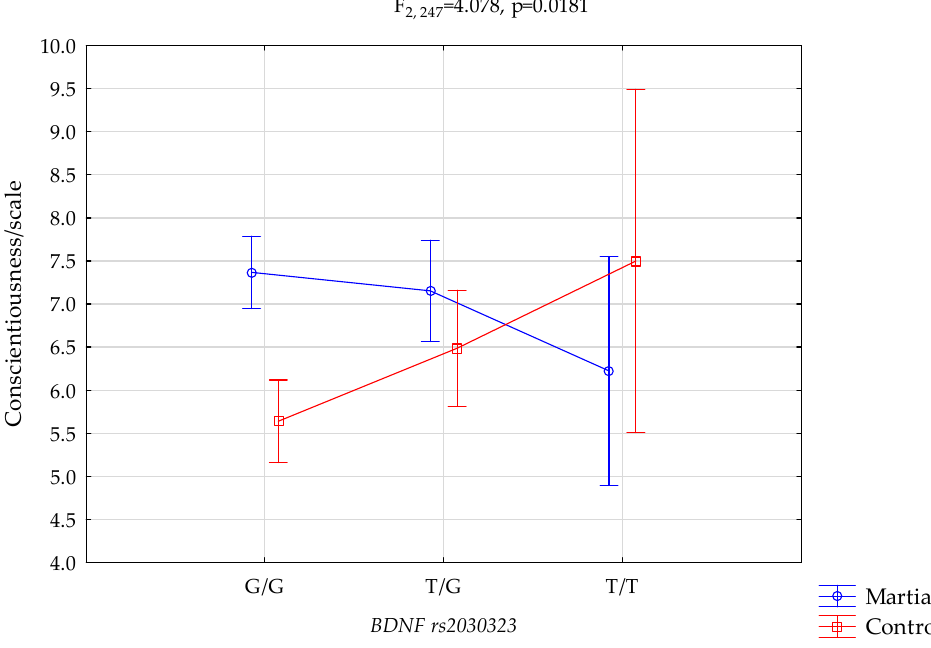
Figure 2. Interaction between s martial arts/control and BDNF rs2030323 and conscientiousness scale.